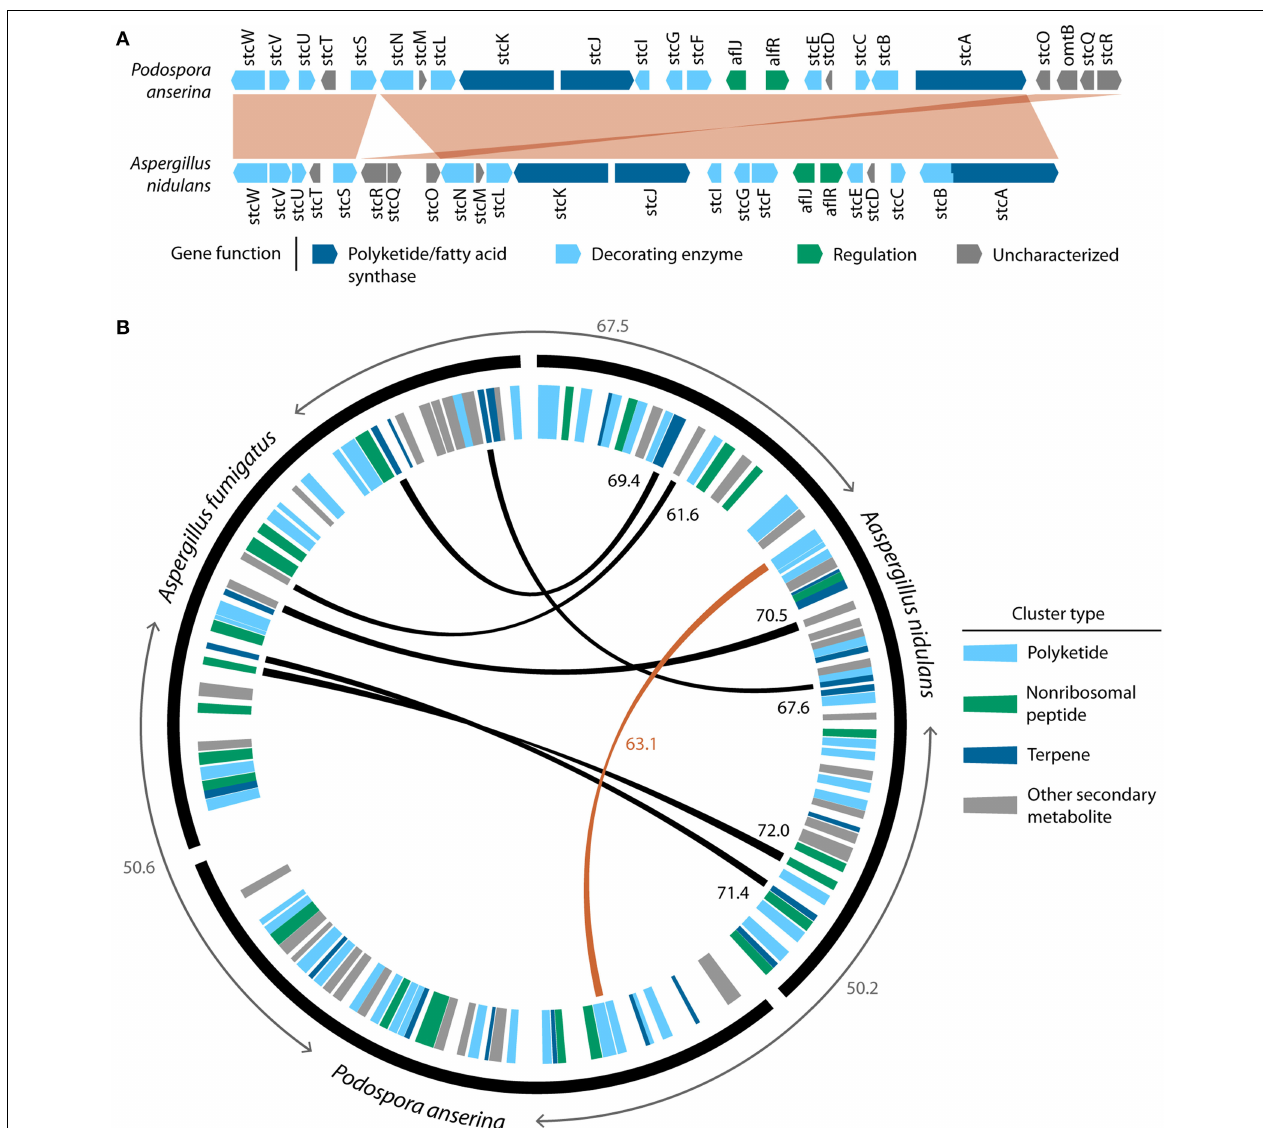
FIGURE 2 | The remarkable similarity of the sterigmatocystin MGC between Aspergillus nidulans and Podospora anserina , two organisms belonging to different fungal classes, is evidence of HGT. (A) Synteny conservation between the sterigmatocystin MGC from Podospora anserina and Aspergillus nidulans. Aligned regions were drawn using the progressive Mauve algorithm (Darling et al., 2010) and are shown in red. (B) Conservation of SM gene clusters between Podospora anserina, Aspergillus nidulans and Aspergillus fumigatus . Circular tracks were created using Circos (http://circos . ca); the outer black track shows the relative gene counts in each of the three species. However, to visualize the relative location of SM gene clusters, the width of genes in these clusters have been drawn at 20 times the width of unclustered genes. Average amino acid percent identities (%IDs) of all